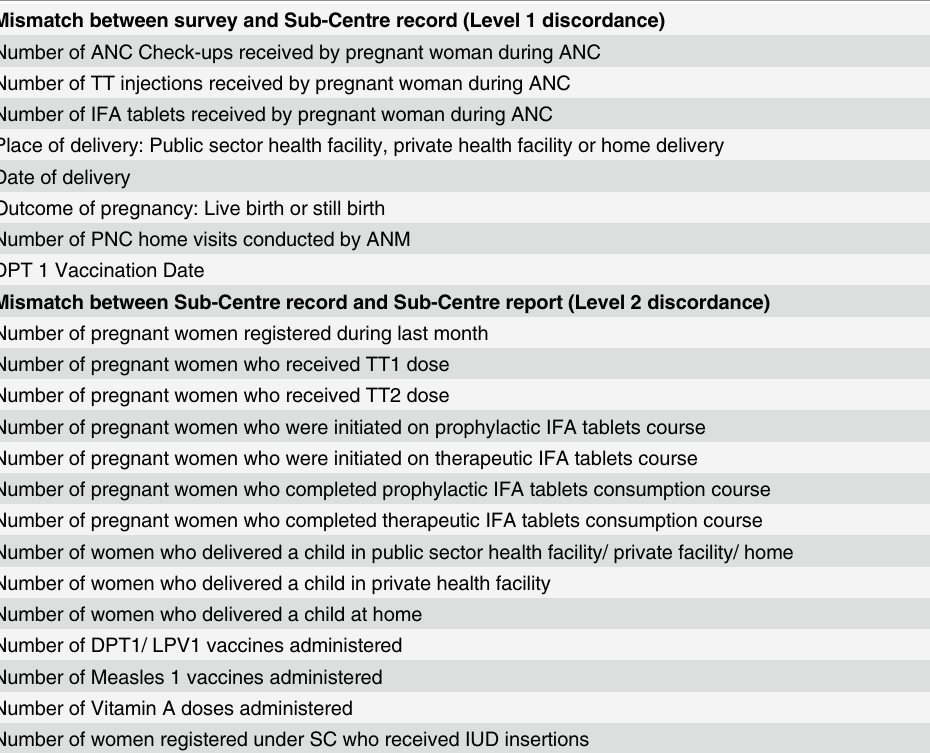
Table 1. Data elements for assessing quality of health management information system in Haryana state, India. Mismatch between survey and Sub-Centre record (Level 1 discordance) Number of ANC Check-ups received by pregnant woman during ANC Number of TT injections received by pregnant woman during ANC Number of IFA tablets received by pregnant woman during